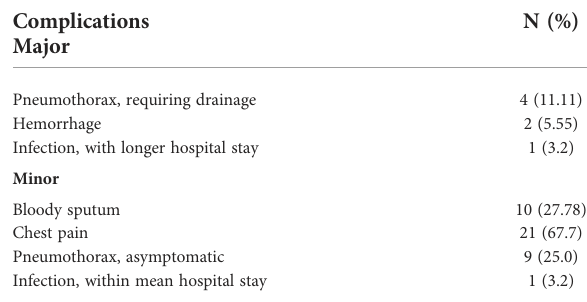
TABLE 3 Complications of percutaneous